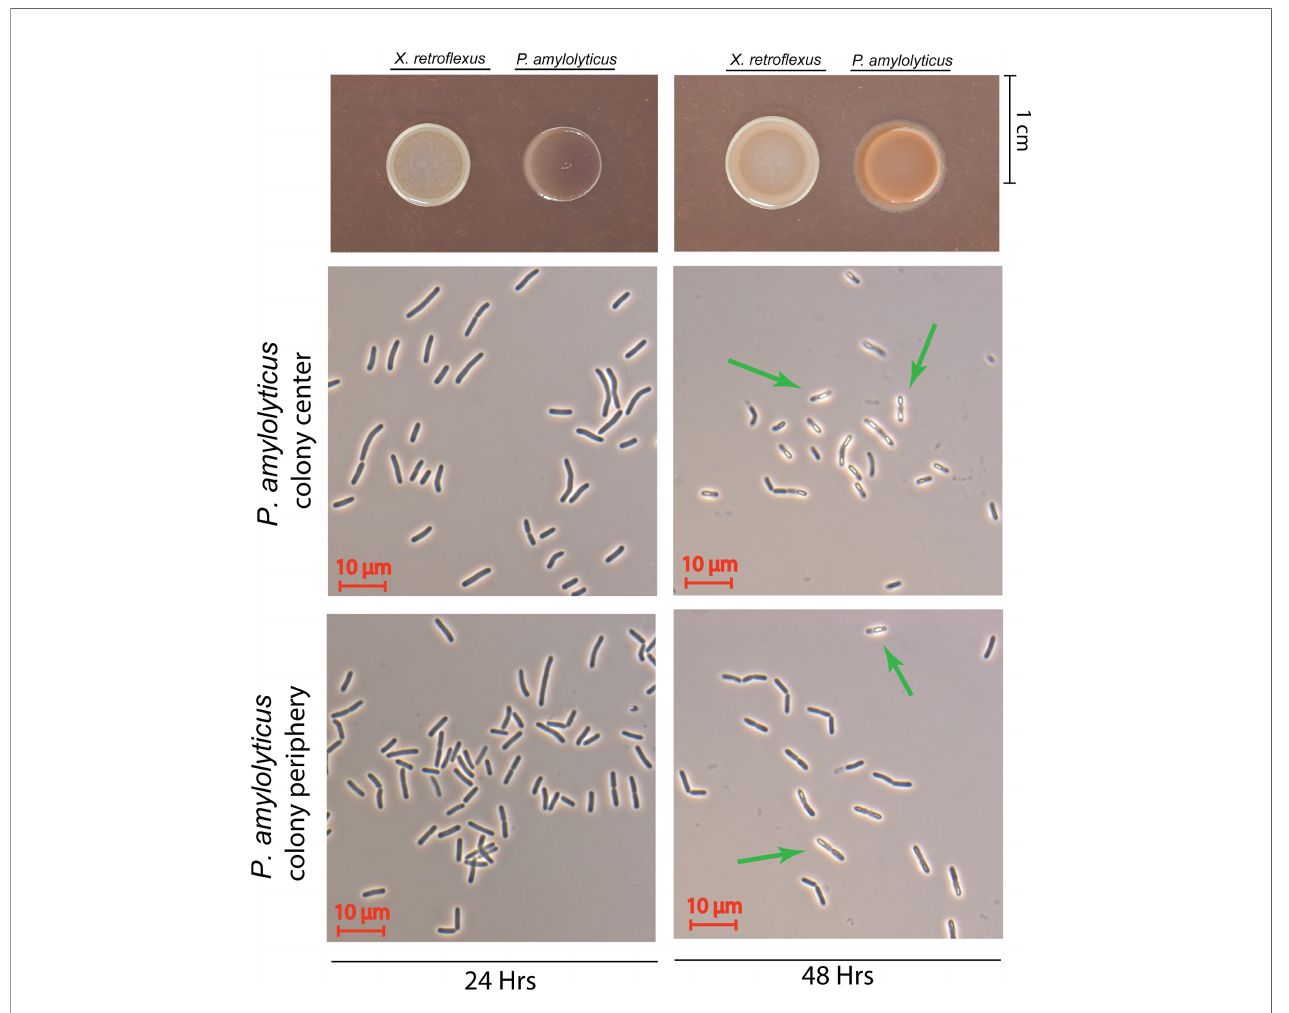
FIGURE 5 | Phase contrast microscopy of the interacting P. amylolyticus colony. At 24 hrs neither the colony center nor the colony periphery showed any visual sporulating bacteria. After 48 hrs the presence of sporulating bacteria was observed in the center of the colony, whereas no visible sporulation was observed at the colony periphery. Green arrows mark bacteria with visible spores. Microscopy images of non-interacting P. amylolyticus is available as Figure S15